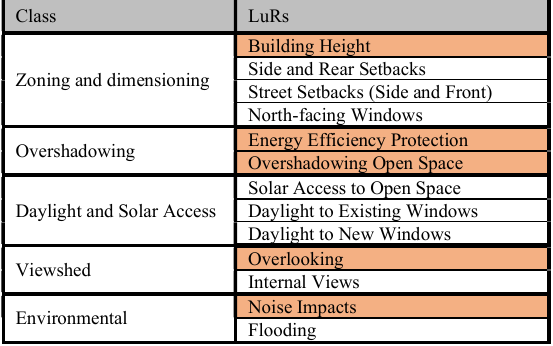
Table 1 . Inventory of 3D LuRs and their categories (in orange, selected LuRs for tests) 3.1.1